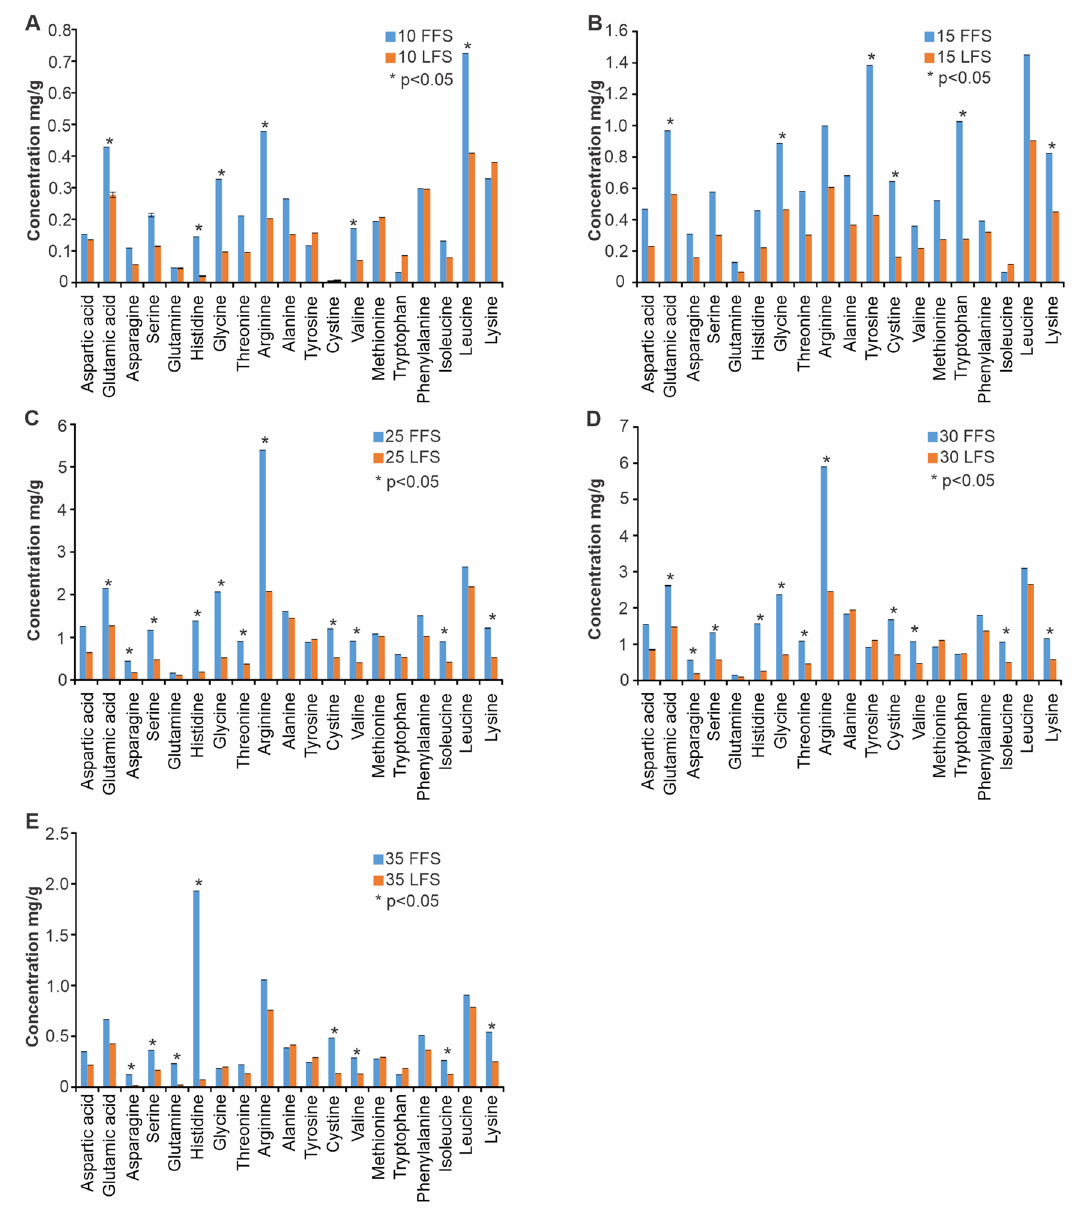
Figure 2. Composition of free amino acids (mg/g) in two types of fish ensilages (FFS—fat fish silage; LFS—lean fish silage) during 35 days of fermentation (DoF). Data are mean ± SD. * p <